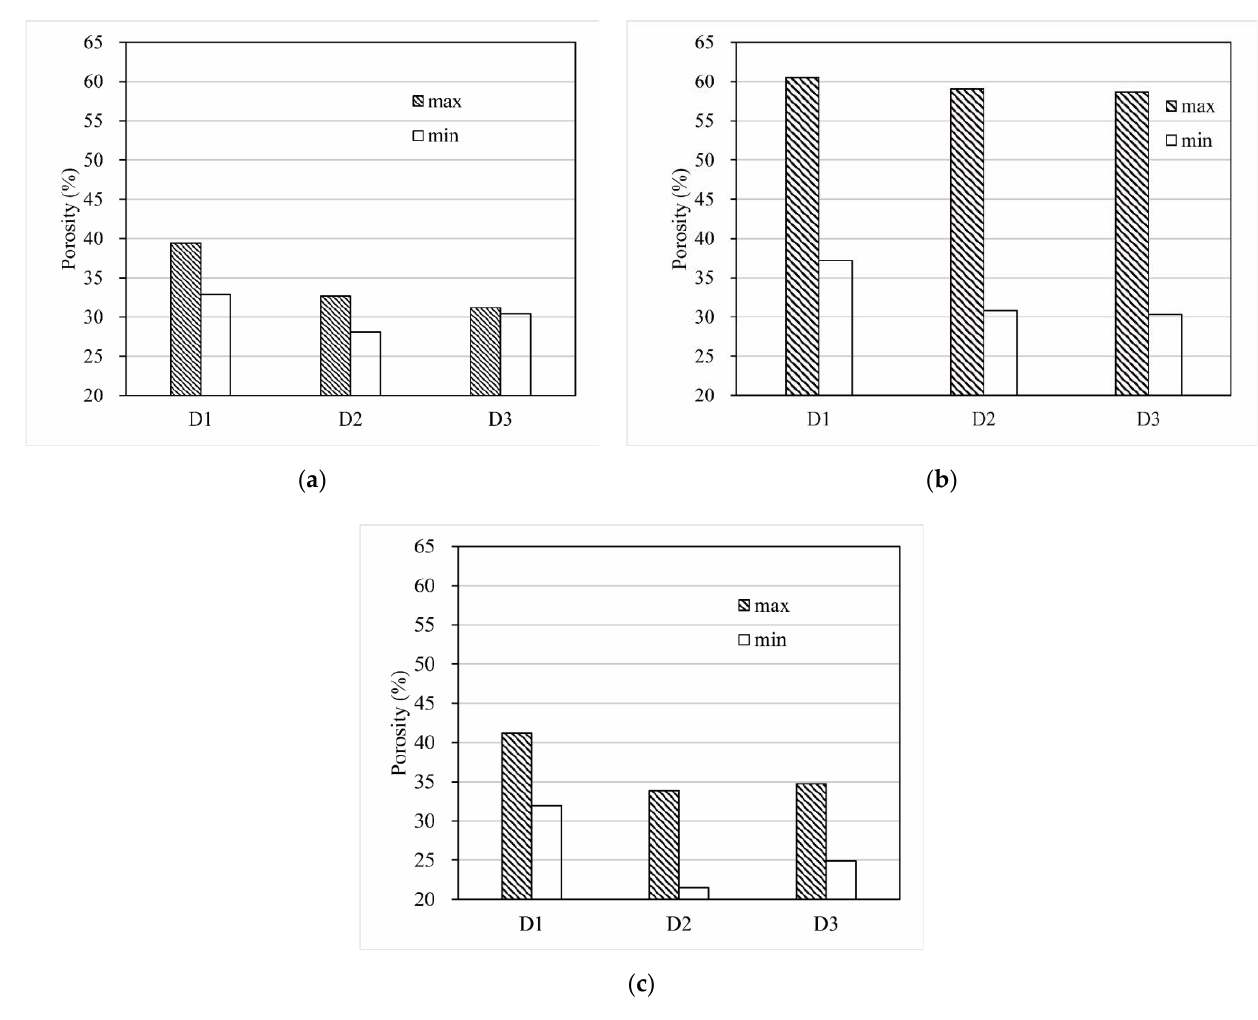
Figure 8. The porosities of the packs. ( a ) The porosities of the glass ball packs. ( b ) The porosities of the gravel packs. ( c ) The porosities of the plastic octahedron packs.